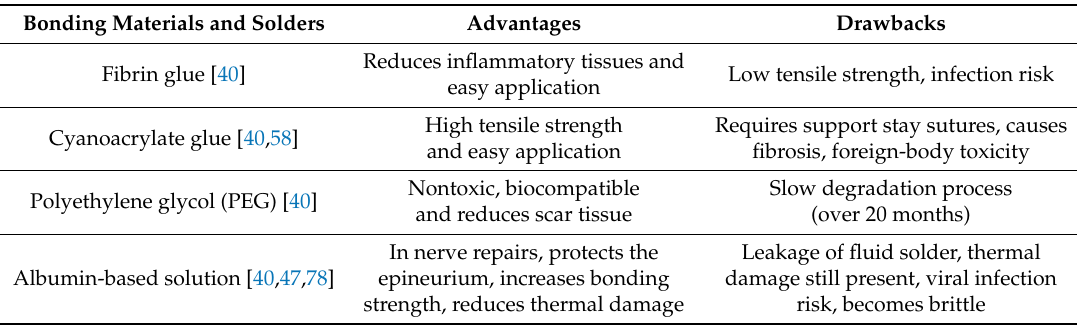
Table6. Advantagesanddrawbacksofsoldersandbondingmaterialsusedinvascularandnerverepairs.